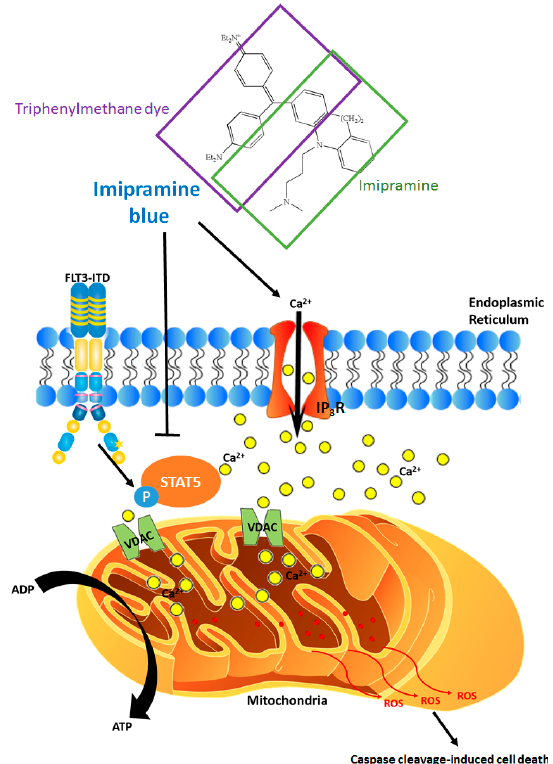
Figure 3. Non-canonical STAT5 activation in leukemia and therapeutic targeting using novel endoplasmic reticulum (ER)-targeted chimeric drugs. FLT3 mutants are defective in glycosylation and are trapped on the ER, near the surrounding areas of high local concentrations of ROS, which conveniently leads to favorable conditions for phosphorylation of STAT5. Drugs that are selectively trapped in the ER-lysosome compartments can suppress local ROS. An example is shown of Imipramine Blue, a chimeric drug that combines a triphenylmethane backbone (purple) with imipramine (green), an FDA approved anti-depressant. Agents with this potential are ideal candidates for leukemia selective indirect targeting of STAT5. Alternatively, drugs that induce calcium release from the ER or increase mitochondrial sensitivity to released calcium have the potential to induce mitochondrial outer membrane permeabilization and caspase cleavage-induced cell